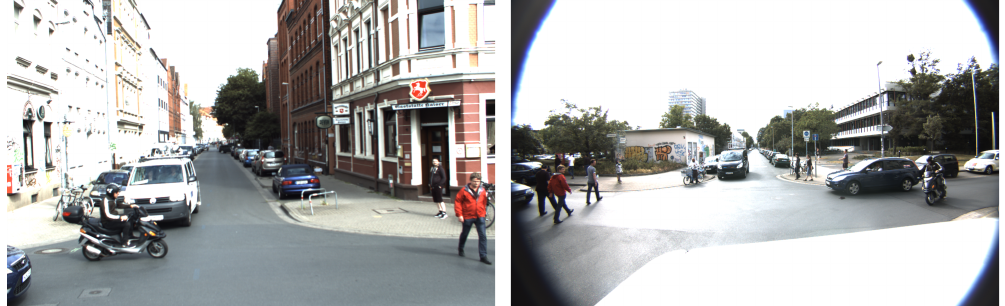
Figure 19. Pedestrians are observed from two cameras in the